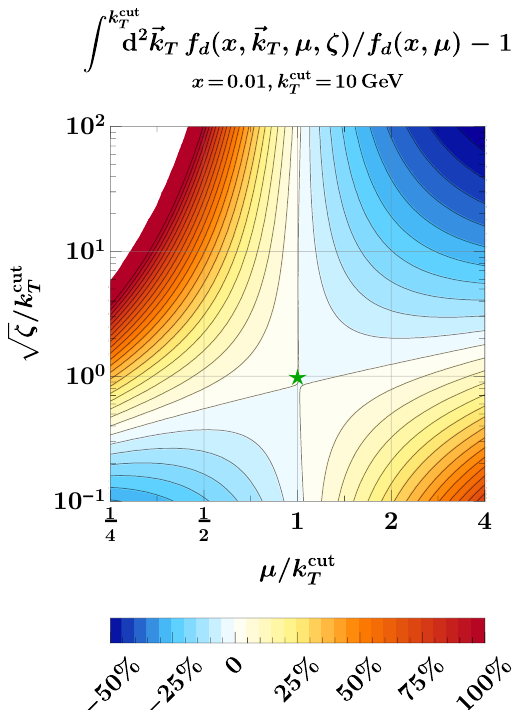
Figure 8 . The normalized deviation of the transverse-momentum integral of the TMD PDF from the collinear PDF as a function of the evolution scales µ and ζ . The green star marks µ = The countour lines indicate increments of five percent points. There are only percent-level deviations √ in the vicinity of µ = ζ = k cut . For µ = k cut , the evolution of ζ is negligible and only a T T